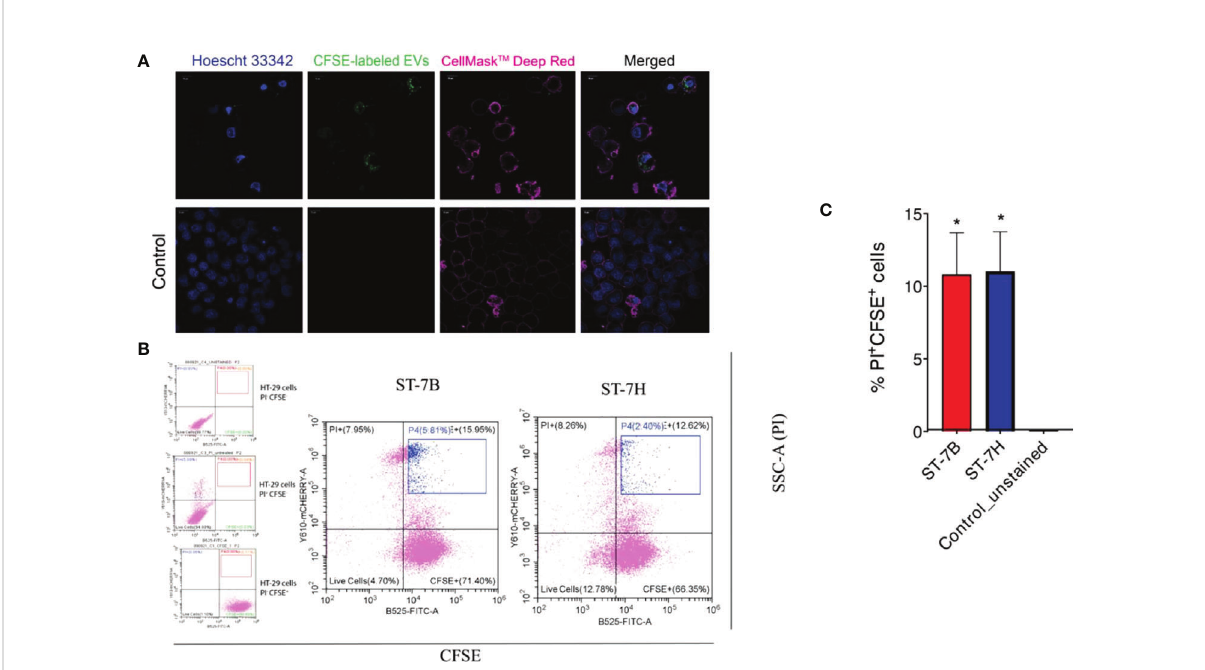
FIGURE 3 Uptake of Blastocystis EVs by HT29 cells leads to an increase in cell death. (A) Confocal microscopy images showing HT29 cells taking up Blastocystis EVs (HT29 nuclei stained blue with Hoescht 33342, HT29 cell membrane stained pink with CellMask ™ Deep Red, EVs stained green with CFSE). Scale bars = 10 µm. (B) Flow cytometry analysis of HT29 uptake of Blastocystis EVs. FITC signal (x-axis) represents CFSE staining; mCherry signal (y-axis) represents propidium iodide staining. Cells in the blue gate have taken up EVs and are nonviable. (C) Proportion of nonviable cells with CFSE-stained EV uptake presented as mean ± SEM. n=3 independent experiments.